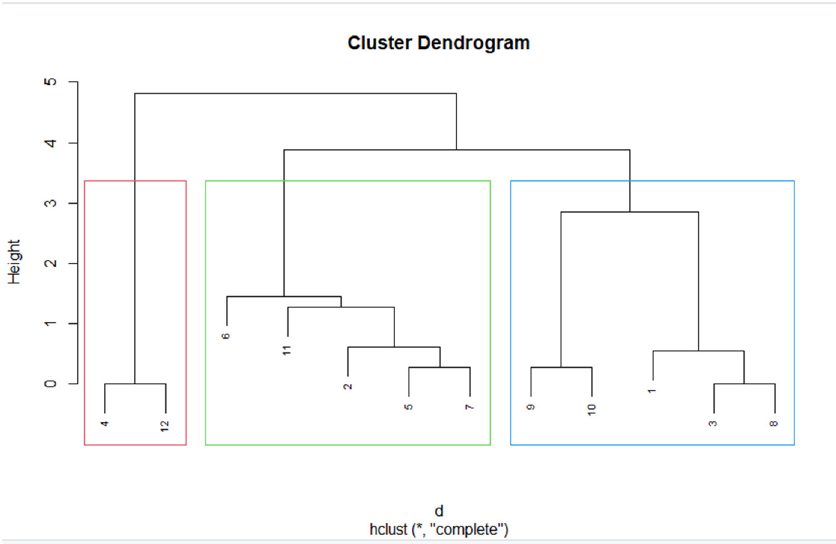
Figure 6. Dendrogram (“complete” method).* - hclust command options.